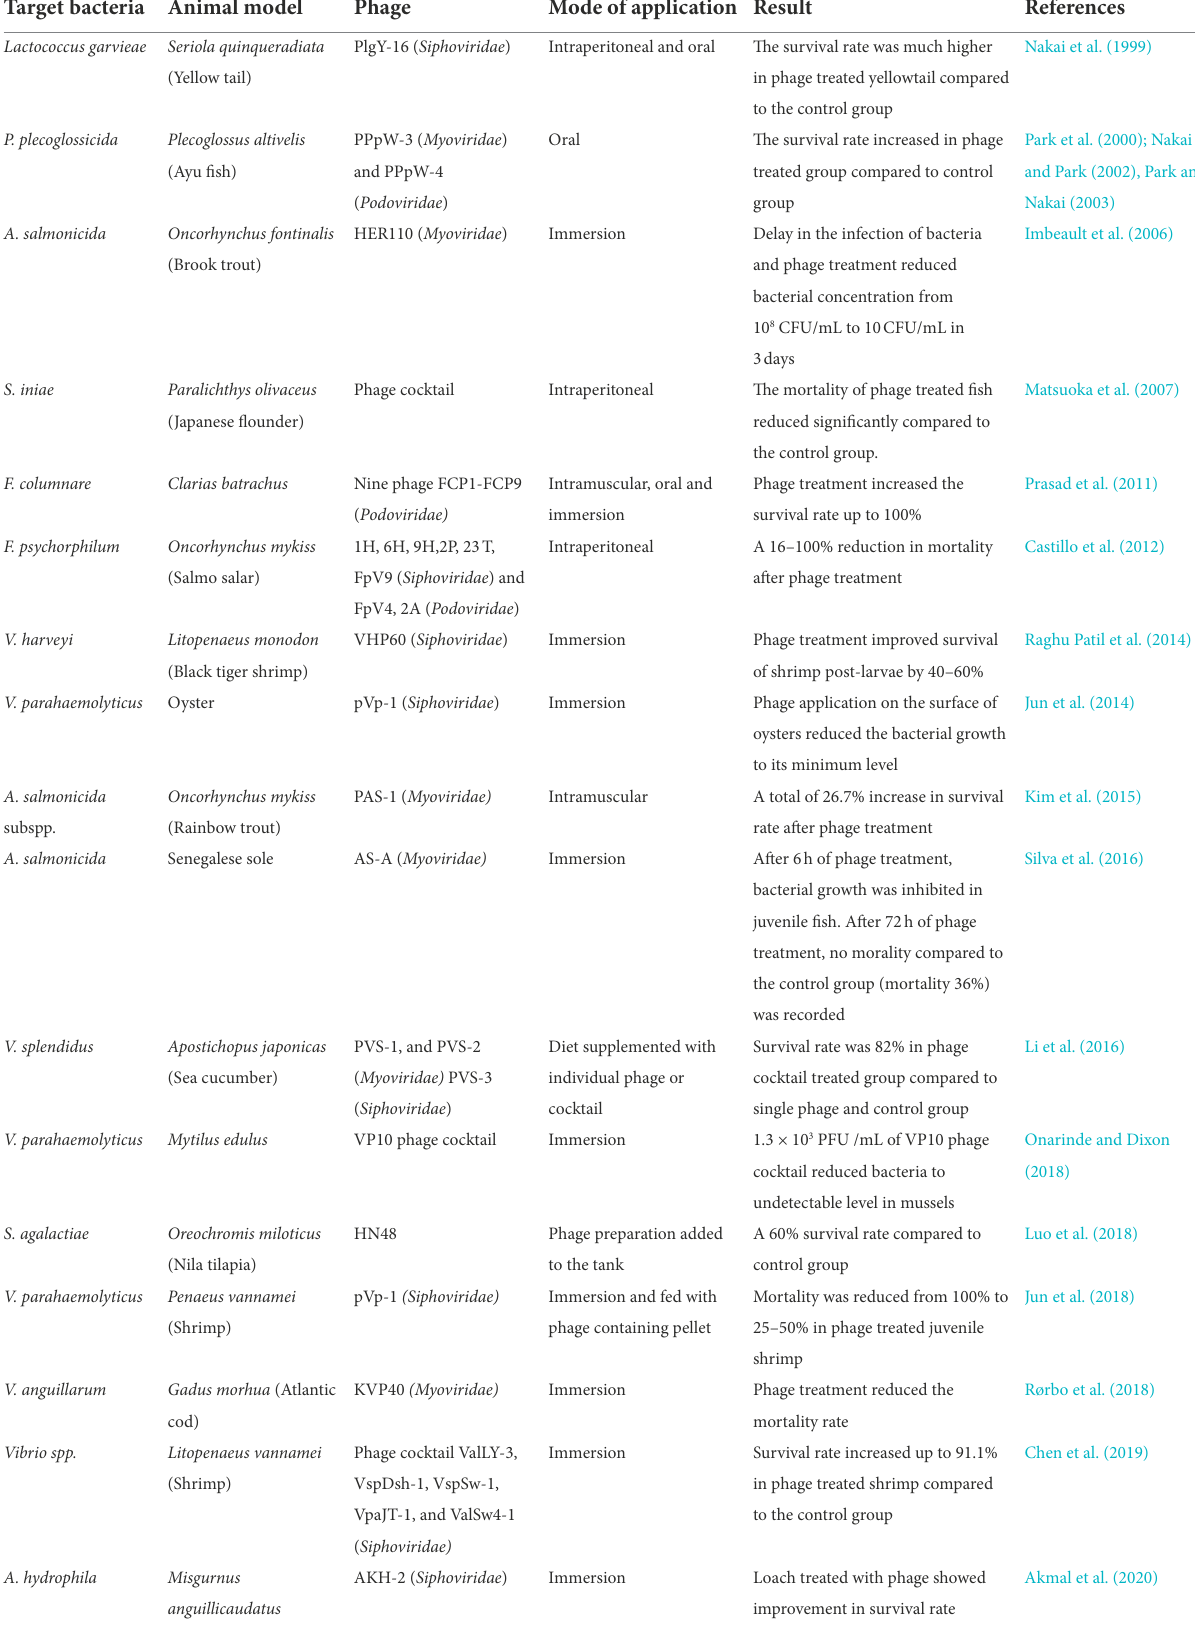
TABLE 2 Summary of phage biocontrol in aquaculture. Target bacteria Animal